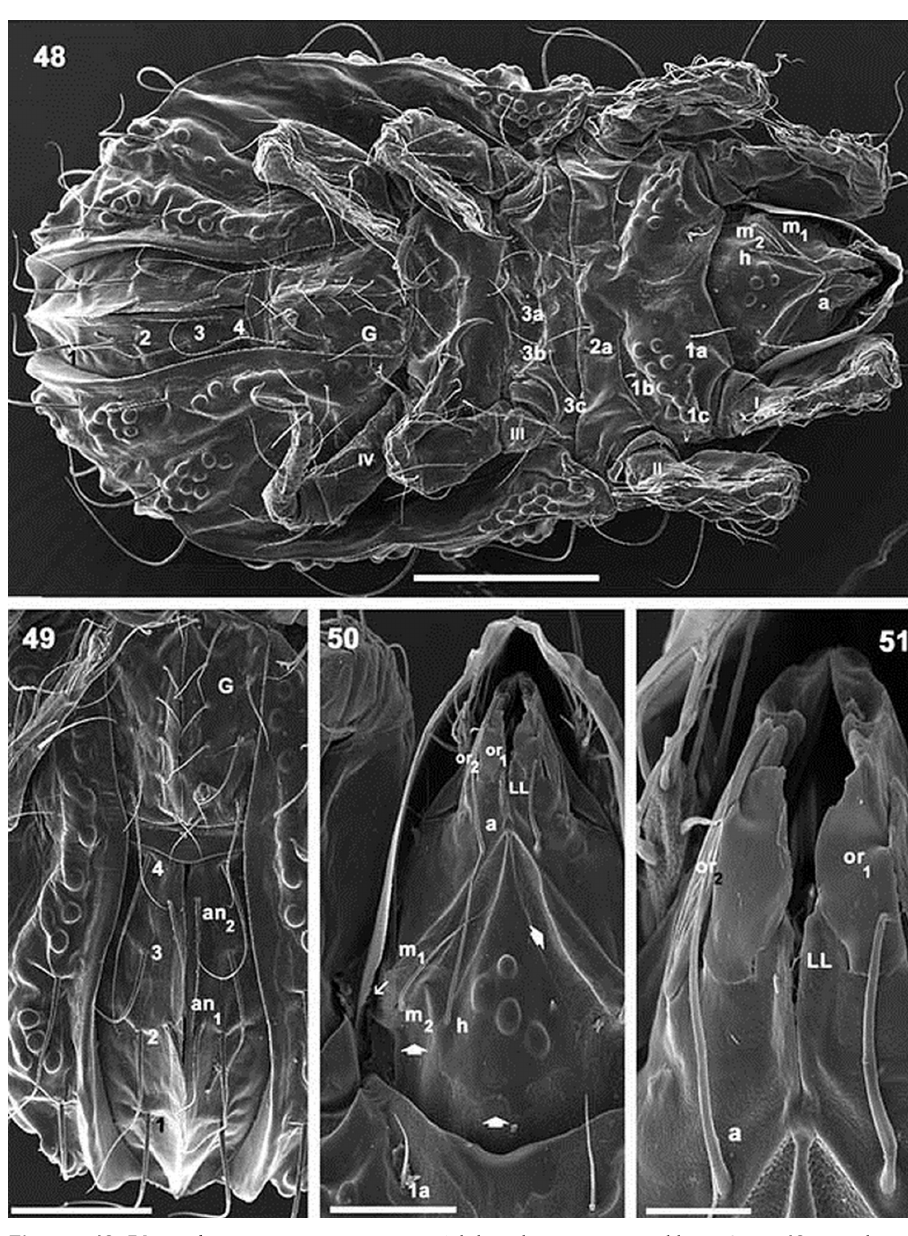
Figures 48–51. Paulianacarus costaricensis sp. n. Adult with cerotegumental layer. SEM. 48 ventral view 49 anogenital region 50 infracapitulum 51 apical infracapitular zone. Abbreviations: See Material and methods. Scale bars: 48 = 200 μm; 49 = 100 μm; 50 = 50μm; 51 =